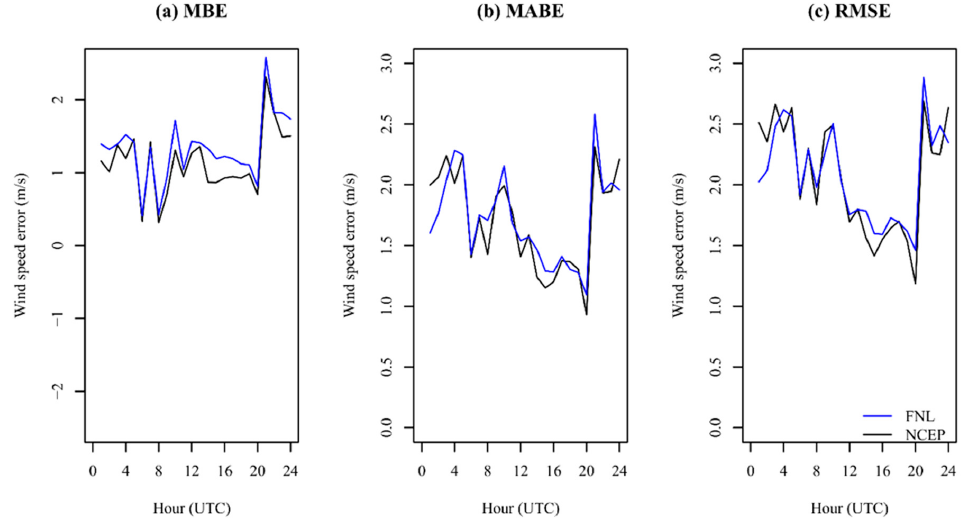
Figure 7. 10 m level wind speed error variations by hour for April 2003 for Crown Point.